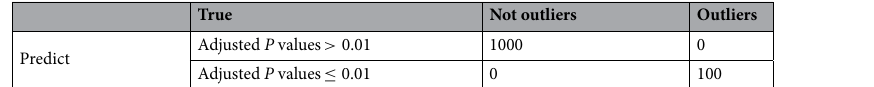
True Not outliers Outliers Adjusted P values > 0.01 1000 0 Predict Adjusted P values ≤ 0.01 0 Table 2. Averaged confusion matrix of Gaussian distribution with outliers and prediction using optimized SD.